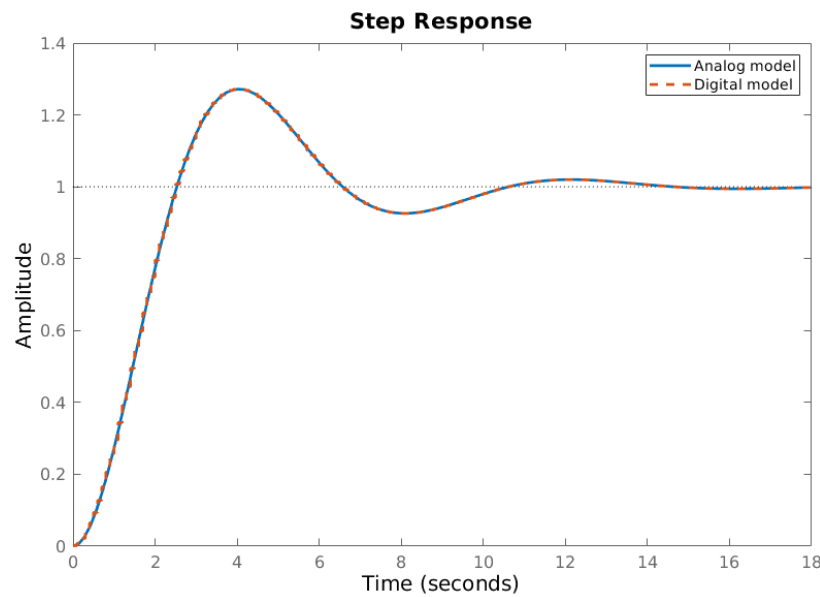
Figure 1. Comparison of the analog and digital models of the oscillatory system for ω 0 = 8.41 · 10 − 1 ,